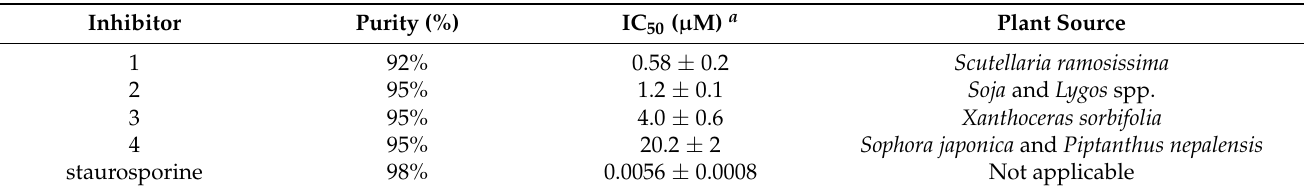
Table 1. Purity data, IC 50 values, and plant sources for the four natural-product inhibitors of PIM1.